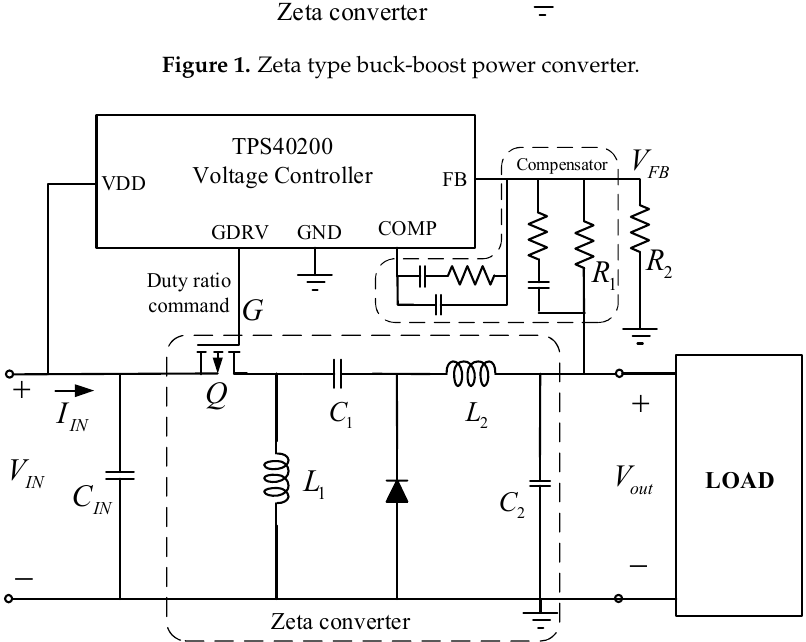
Figure 2. Voltage regulated Zeta type buck-boost DC to DC power converter. V The output voltage out